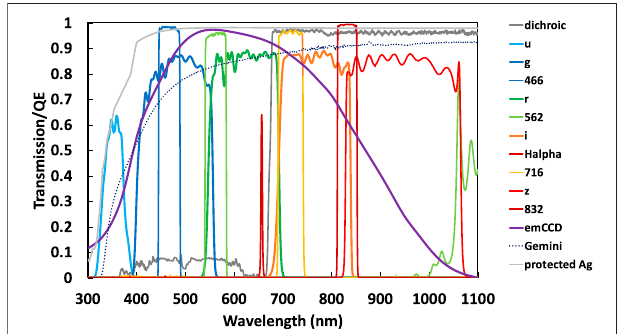
FIGURE 3 | The EMCCD Quantum ef fi ciency curve for the Andor iXon Ultra 888 EX cameras is shown here along with the overall Gemini telescope transmission curve. ‘ Alopeke and Zorro have a single Ag pickoff mirror whose transmission is also shown here. Within the instruments, the dichroic divides the incoming beam into red and blue channels at 674 nm. Each channel has a fi lter wheel with two narrow-band fi lters for speckle observations,whicharecenteredat466,562,716,and832 nm.Inadditionto the narrow fi lters, each wheel has wide-band SDSS (ugriz) fi lters suitable for broadband photometryand imaging. Thedata for these curves weresupplied by the respective manufacturers. Note: the Ag curve describes re fl ection, not transmission for the pickoff mirror. The Gemini curve represents the total transmission for the telescope prior to the instrument and was provided by Gemini